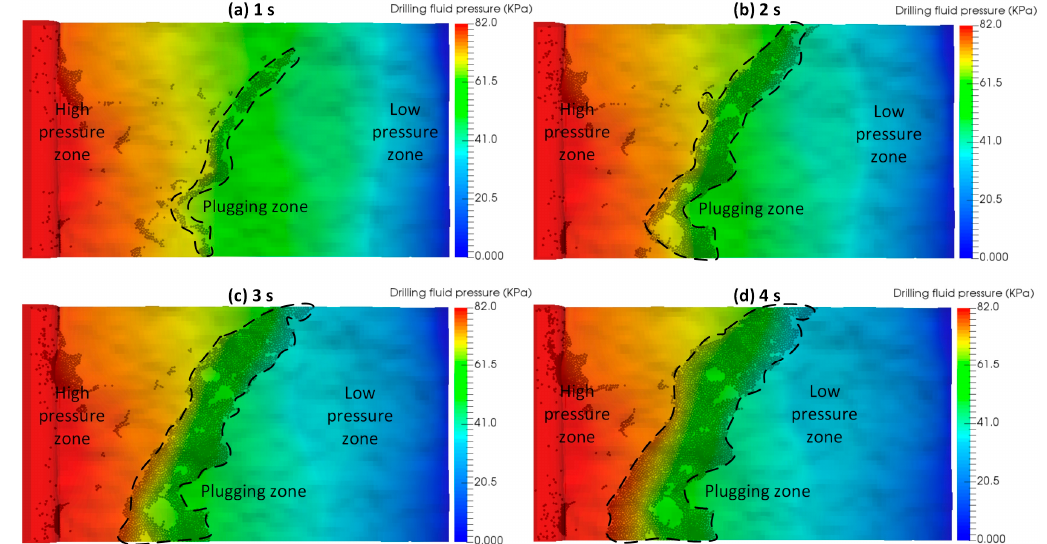
Figure 9. LCM particles formed the plugging zone preventing pressure propagation.